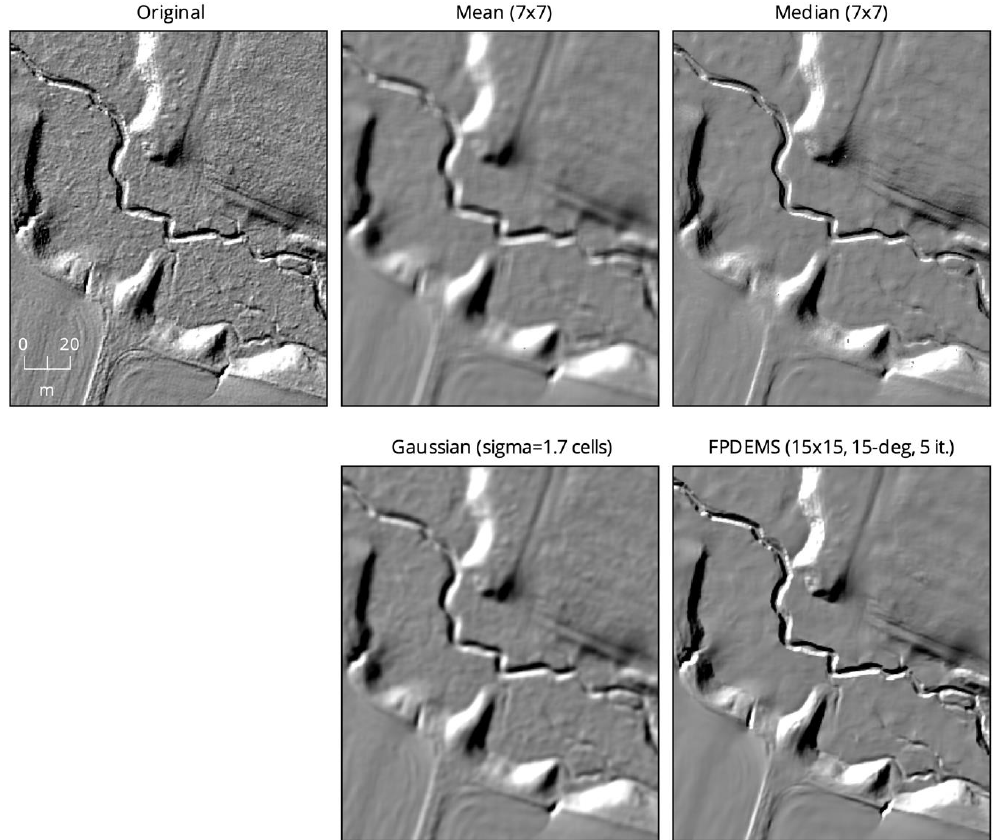
Figure 10. A comparison of the mean, median, and Gaussian low-pass filters and the FPDEMS method for smoothing a small incised stream within the study site DEM. A small yazoo tributary stream flows along the base of the lower terrace scarp, near the bottom-right corner. Images present portions of the shaded relief images extracted from each